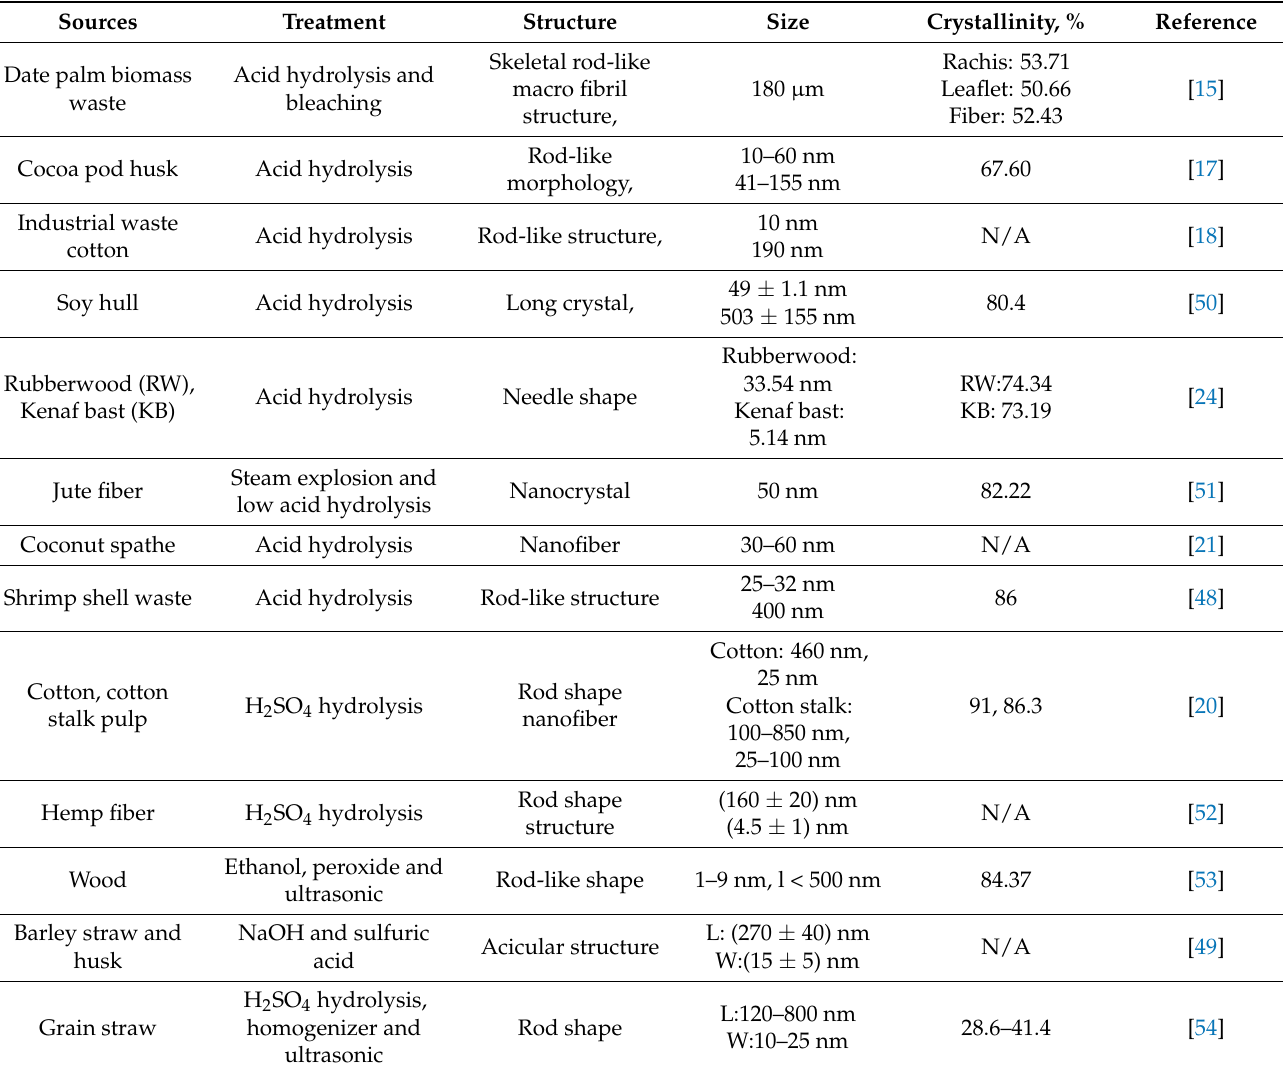
Table 2. Properties of cellulose from different sources and extraction